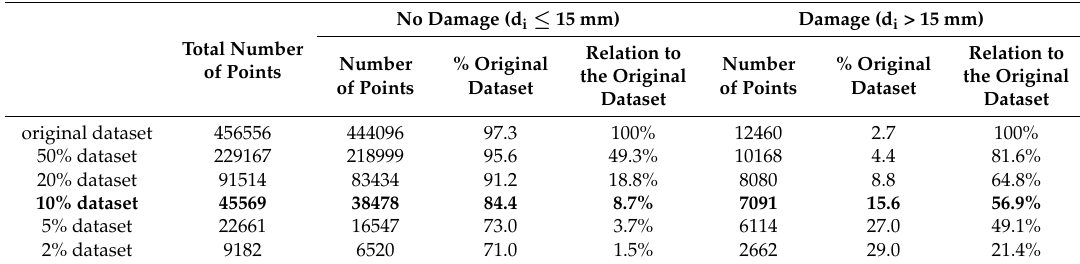
Table 3. Results of processing with the OptD method—brick wall.